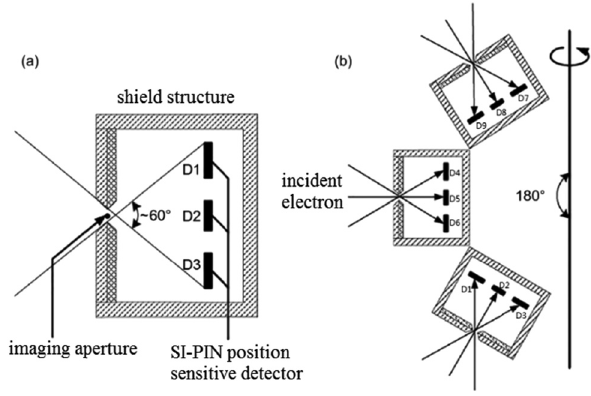
Figure 1: Structure schematic diagram of IES - II detector. ( a ) Structure of probe and ( b ) structure diagram of the IES - II detector.